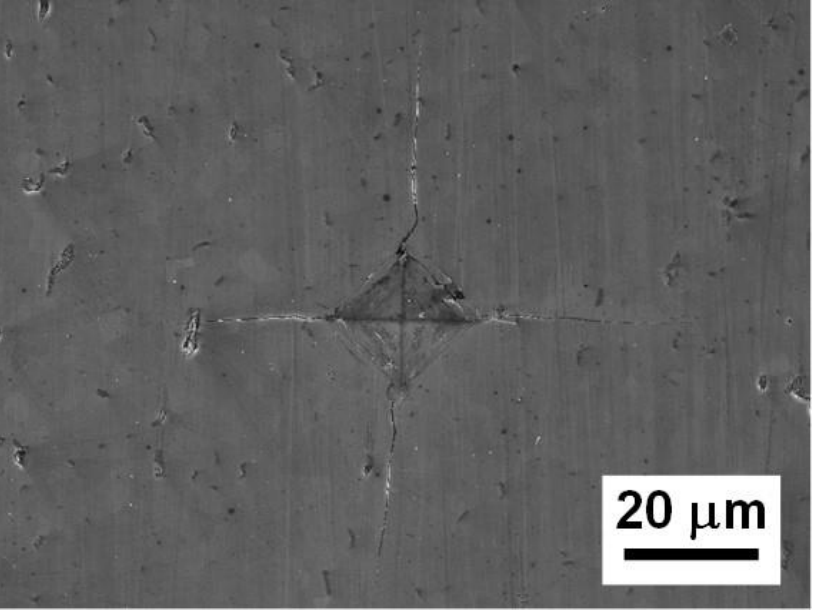
Figure 6. SEM micrograph of Vickers hardness impression in B 4 C made at 1kg indentation load.